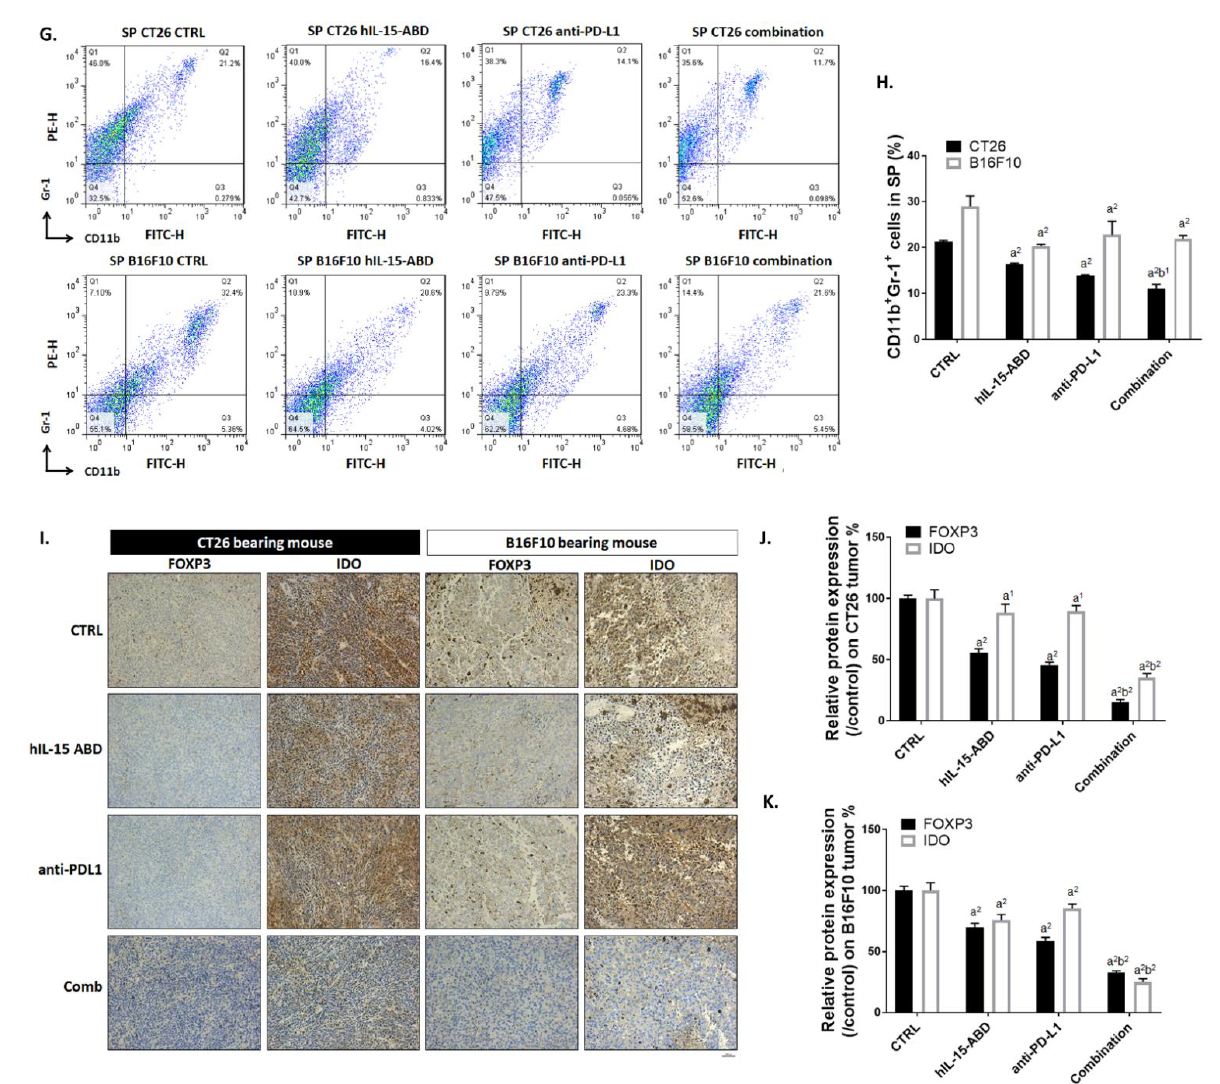
Figure 7. hIP-15-ABD combined anti-PD-L1 antibody successfully suppress the accumulation of immunosuppressive cells. ( A , C ) Flow cytometry pattern and ( B , D ) quantification results of CD3 - /CD49b + , CD4 + /CD25 + /FOXP3 + Tregs from TDLN and SP, respectively. ( E , G ) Flow cytometry pattern and ( F , H ) quantification results of CD11b + /Gr-1 + MDSCs from BM and SP, respectively. ( I ) FOXP3 and IDO IHC staining images and ( J , K ) relative quantification of CC and melanoma are presented. (a 1 p < 0.05, a 2 p < 0.01 vs. CTRL; b 1 p < 0.05, b 2 p < 0.01 vs. hIL15-ABD and anti-PD-L1; scale bar = 100 μm).